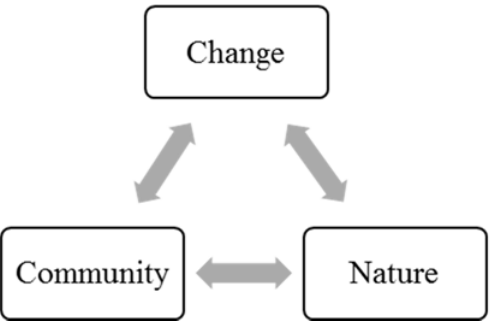
Figure 1. Community interpretation of relationships of change to nature within a